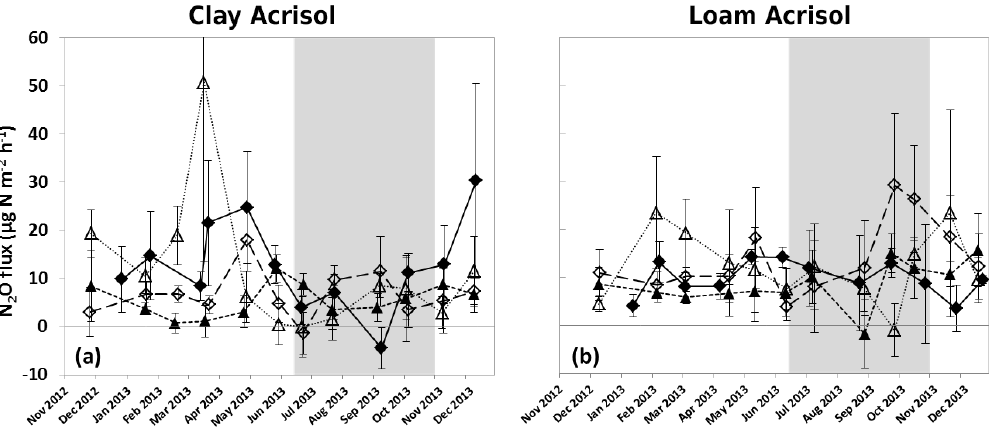
Figure 1. Mean ( ± SE, n = 4 sites) soil N 2 O fluxes from forest ( (cid:7) ), jungle rubber ( (cid:5) ), rubber ( (cid:78) ) and oil palm ( (cid:77) ), located within the clay (a) and loam Acrisol (b) landscapes in Jambi, Indonesia. Measurements were carried out monthly from December 2012 to December 2013; gray shadings mark the dry